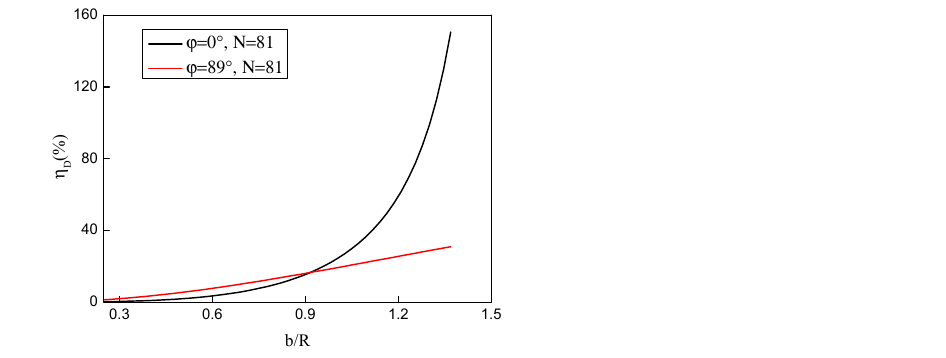
Figure 29. Correlation curves of η (cid:3005) with the ratios of width and radius of the shadow band